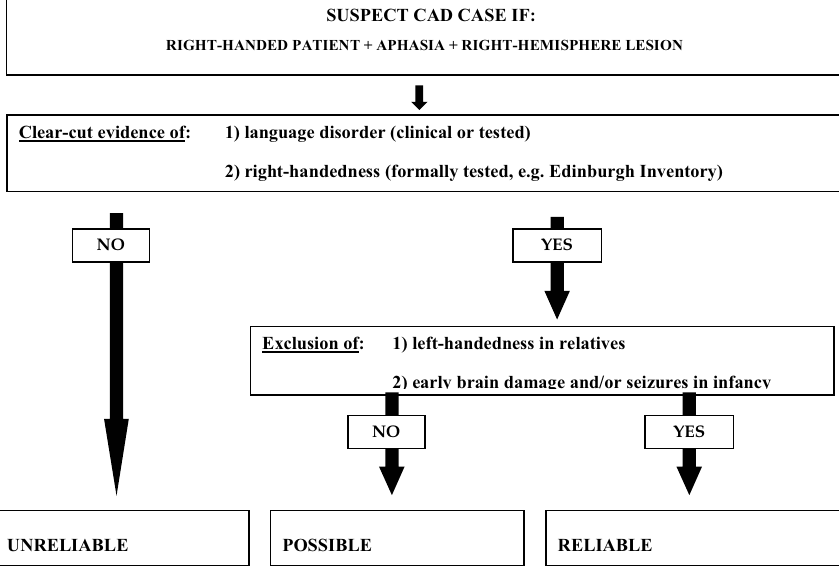
Fig. 3. Algorithm of diagnostic criteria for vascular CAD in adults